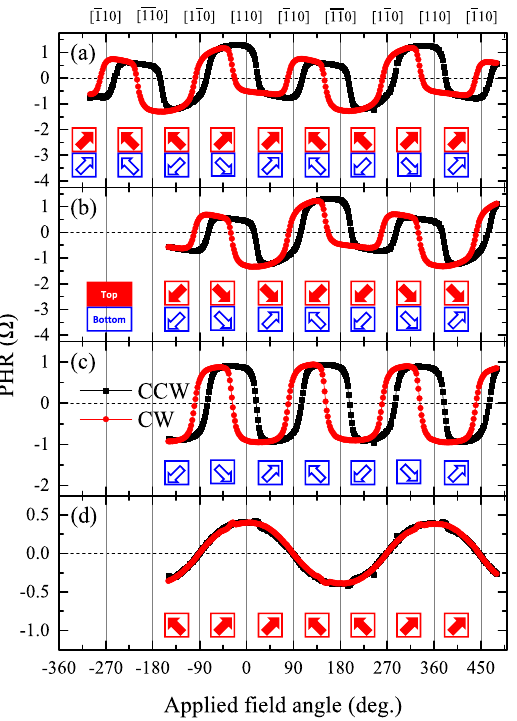
Figure 7. Angular dependences of PHR obtained after initializing magnetization ( a ) in the 1 st quadrant, and ( b ) in the 3 rd quadrant. ( c ) PHR signal of GaMnAs layer with negative Δ R (i.e., bottom layer of the structure) calculated from data in ( a ) and ( b ). The PHR signal from the GaMnAs layer with positive Δ R (i.e., the top layer) obtained by subtracting results in ( c ) from the PHR data in ( a ) is plotted in ( d